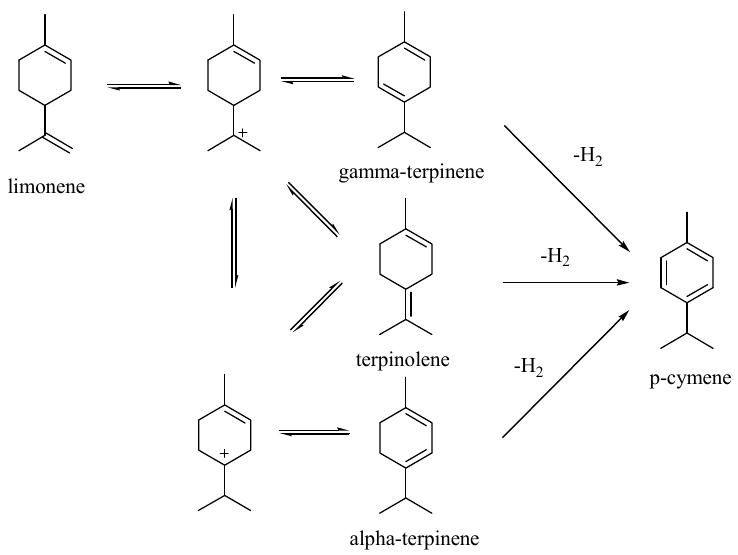
Figure 1. The mechanism of isomerization and dehydrogenation of limonene.